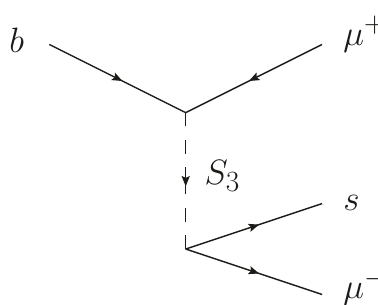
Figure 1 . Our model features an S 3 scalar leptoquark that is charged under L µ − L τ , which therefore couples only to second family leptons. This leptoquark mediates the anomalous b → s‘‘ transitions via a tree-level contribution that induces ∆ C µ